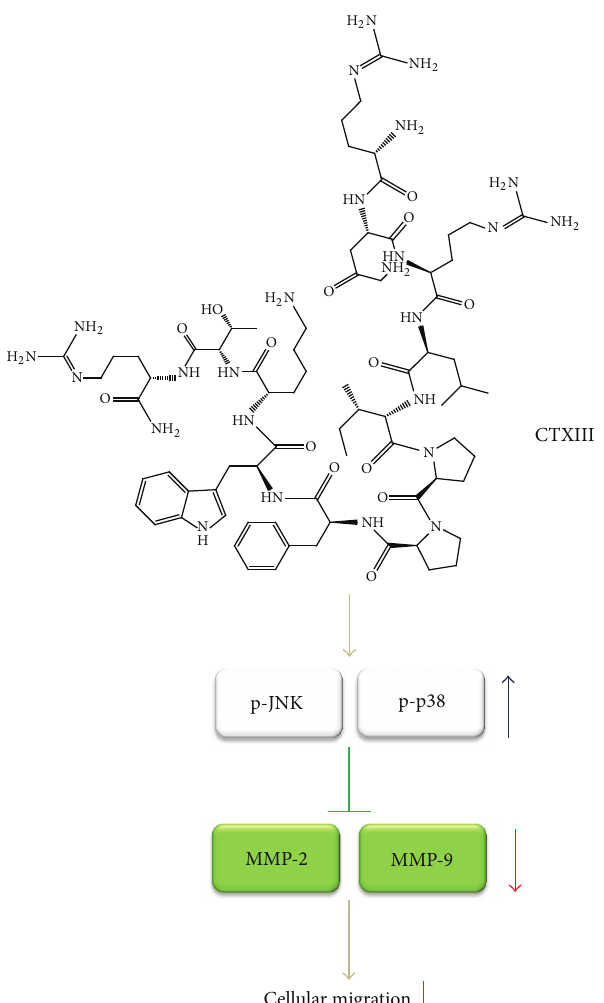
Figure 5: Proposed schematic mechanism of CTXIII-induced antimigration in human oral cancer cells. In current study, CTXIII exerts the antimigration potential against Ca9-22 cells in a dose- responsive manner. CTXIII causes the activation of MAPK mem- ber JNK and p38 without affecting ERK signaling. This may downregulate the expression levels of MMP-2 and MMP-9, the two major migration-associated extracellular matrix proteinases. Finally, the downregulated MMP-2 and MMP-9 expressions result in attenuating the migration potential of Ca9-22